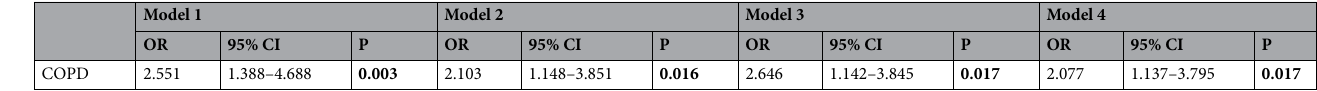
Table 2. Logistic regression analysis to identify association between obstructive pulmonary disease and glaucoma in women. Model 1 univariate analysis; Model 2 multivariate analysis adjusted for age, refractive status, IOP and BMI; Model 3 multivariate analysis adjusted for age, refractive status, IOP, BMI and HTN; Model 4, multivariate analysis adjusted for age, refractive status, IOP, BMI, HTN, smoking status and exercise. OR odds ratio, CI confidence interval, BMI body mass index, COPD chronic obstructive lung disease. Significant values are in bold. A P value < 0.05 was considered statistically significant.